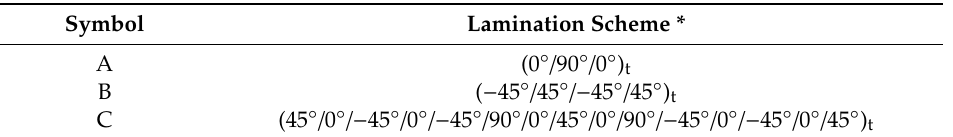
Table 5. Plate lamination schemes.